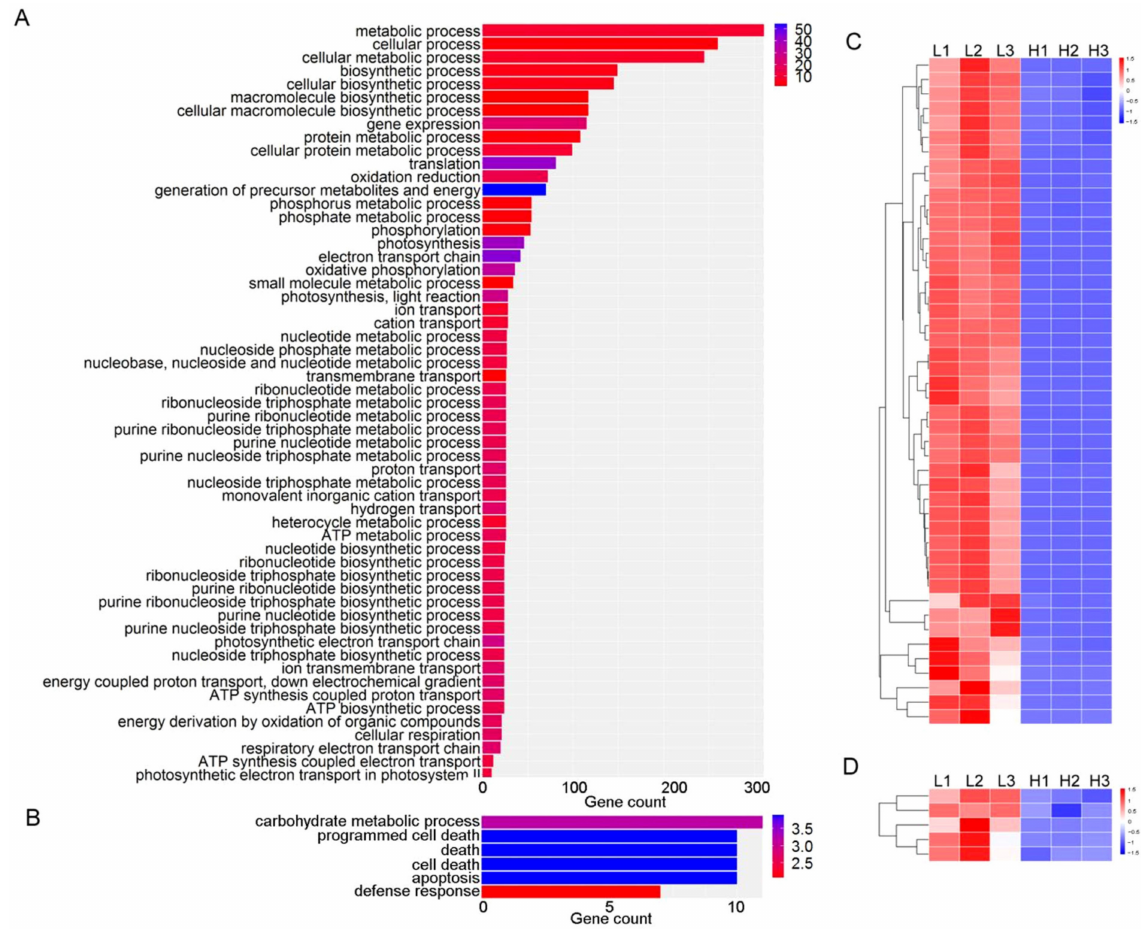
Figure 3. GO enrichment analyses of DEGs. ( A , B ) GO enrichment analyses of DEGs up-regulated in L and H accessions, respectively. ( C , D ) The heat maps of 46 DEGs related to ATP metabolism and 5 DEGs of ethylene-response factors,